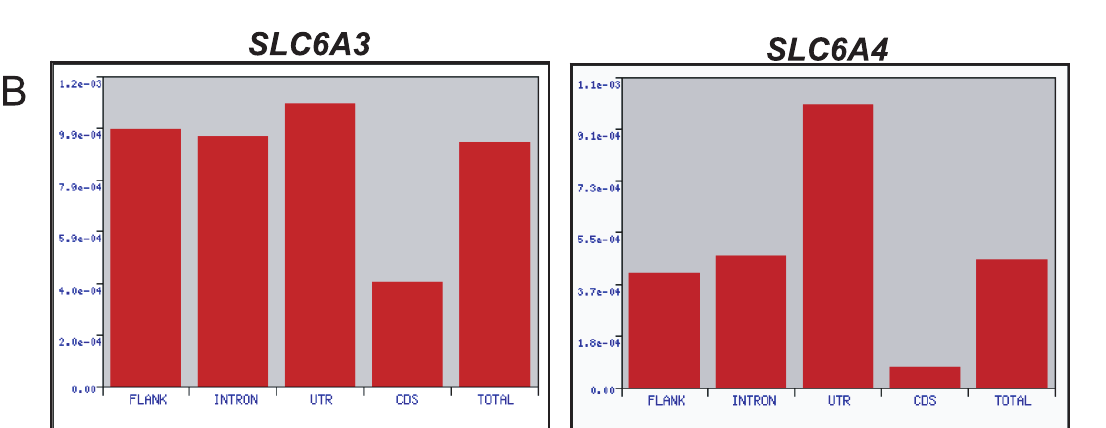
(Table S3). For the potentially novel genotyping targets, we might consider only one region (VARscore 1.36). Of notice, analyses were limited to the gene sequences; therefore the region of the 5- HTTLPR polymorphism was outside the scope.